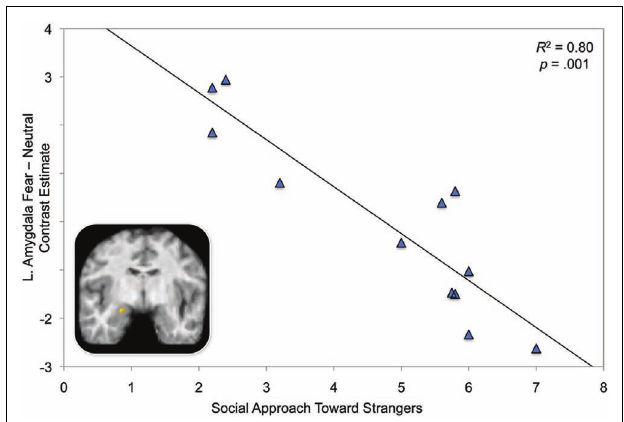
FIGURE 2 | Individual differences in social behavior (SocialApproach Toward Strangers scores) associated with left amygdala response to fearful, compared to neutral, facial expressions inWS. Tendency to approach strangers (as rated by a caregiver) are plotted on the x-axis. Contrast estimates within the left amygdala are plotted on the y-axis. Adapted from Haas et al. (2010)